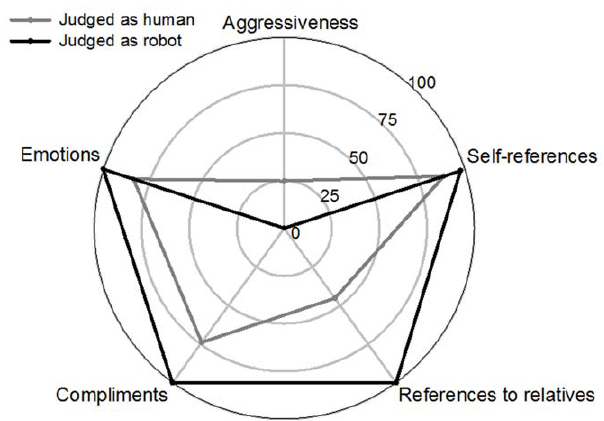
Figure 2. Patterns of behavioral expressiveness of the subjects whether they were perceived as humans or as robots. Patterns are based on the subjects’ results on the five dimensions selected (aggressiveness, self-references, references to relatives, compliments,